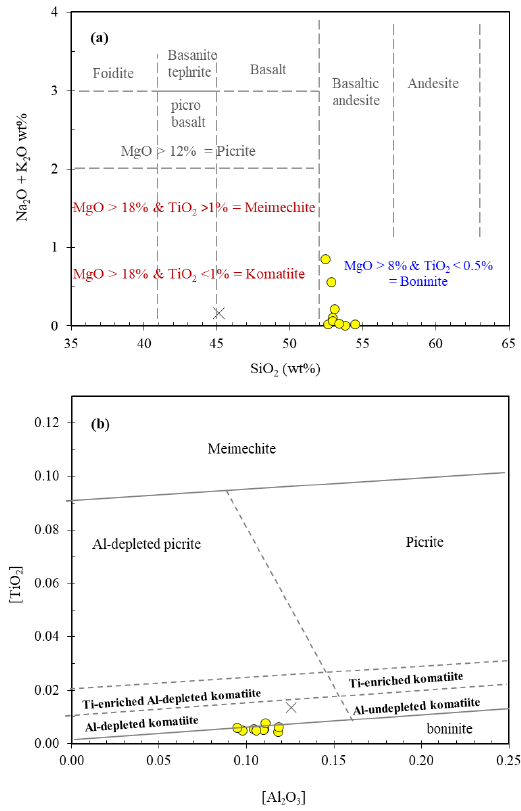
Figure 6. ( a ) SiO 2 vs. (Na 2 O + K 2 O) classification diagram for high-Mg volcanics, after Le Bas [21]; ( b ) Al 2 O 3 vs. TiO 2 classification diagram adopted from Hanski et al. [22]. On the basis of above